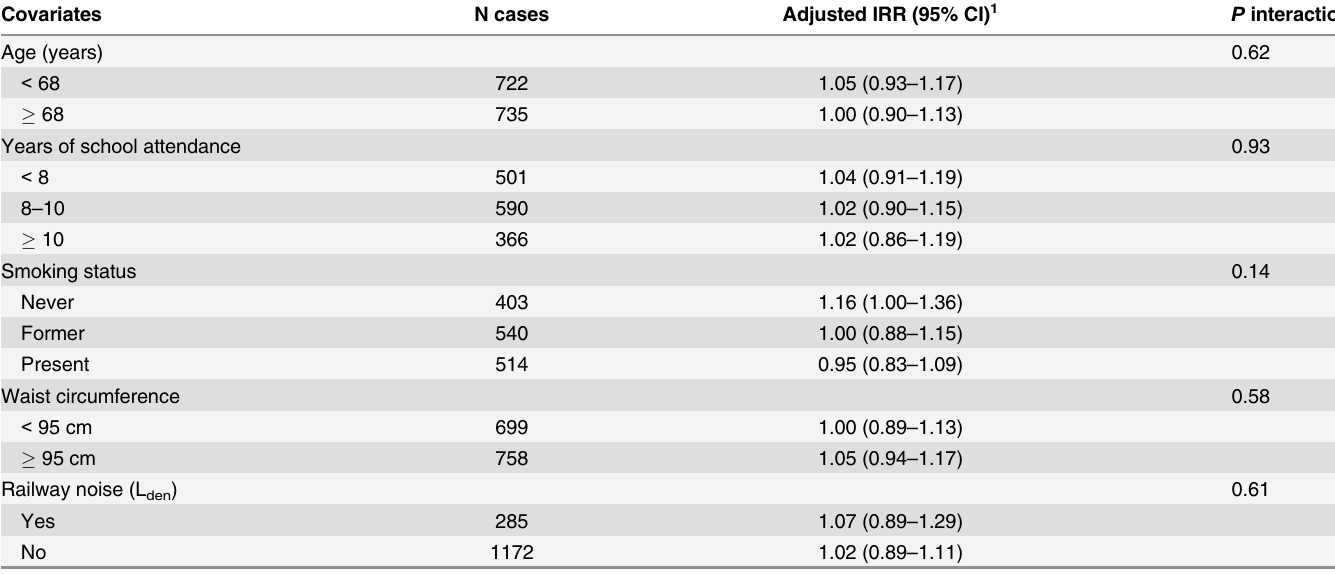
Table 4. Modification of the association between 10-year mean of road traffic noise (per 10 dB) and risk for prostate cancer by different baseline characteristics and age and railway noise at diagnosis.